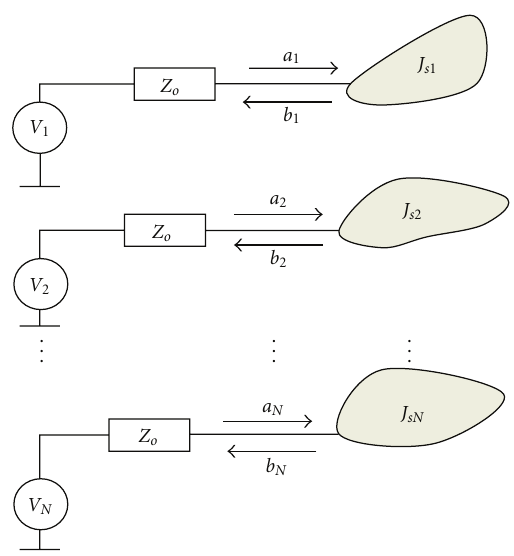
Figure 1: The electromagnetic geometry for the N antenna element